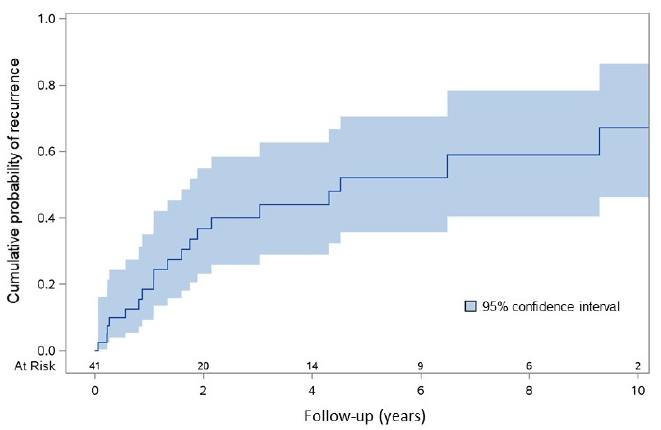
Figure 1. Cumulative probability of recurrence in HCC/PLWH who received IT.